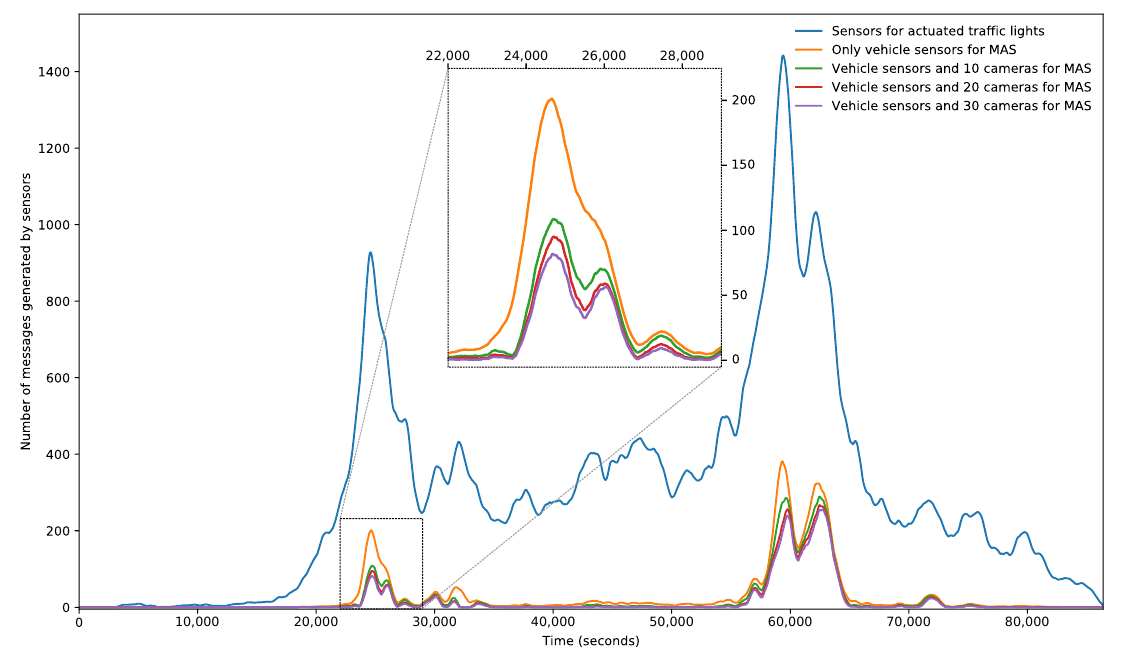
Figure 8. Number of messages generated by the sensor network during the simulation